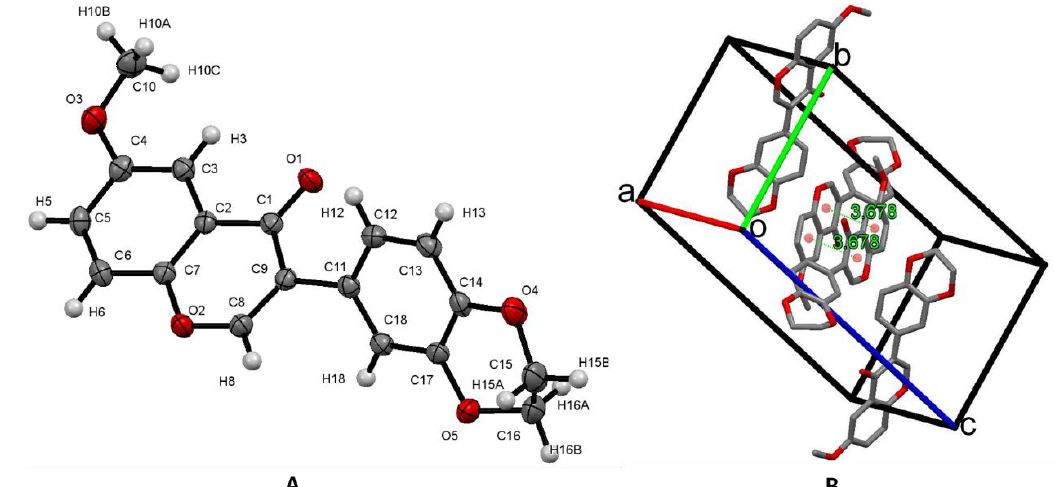
Figure 1. Crystal structure with the label of isoflavone 6 ( A ) and its crystal packing image in a unit cell ( B ). All hydrogens are omitted for clarity in (B).